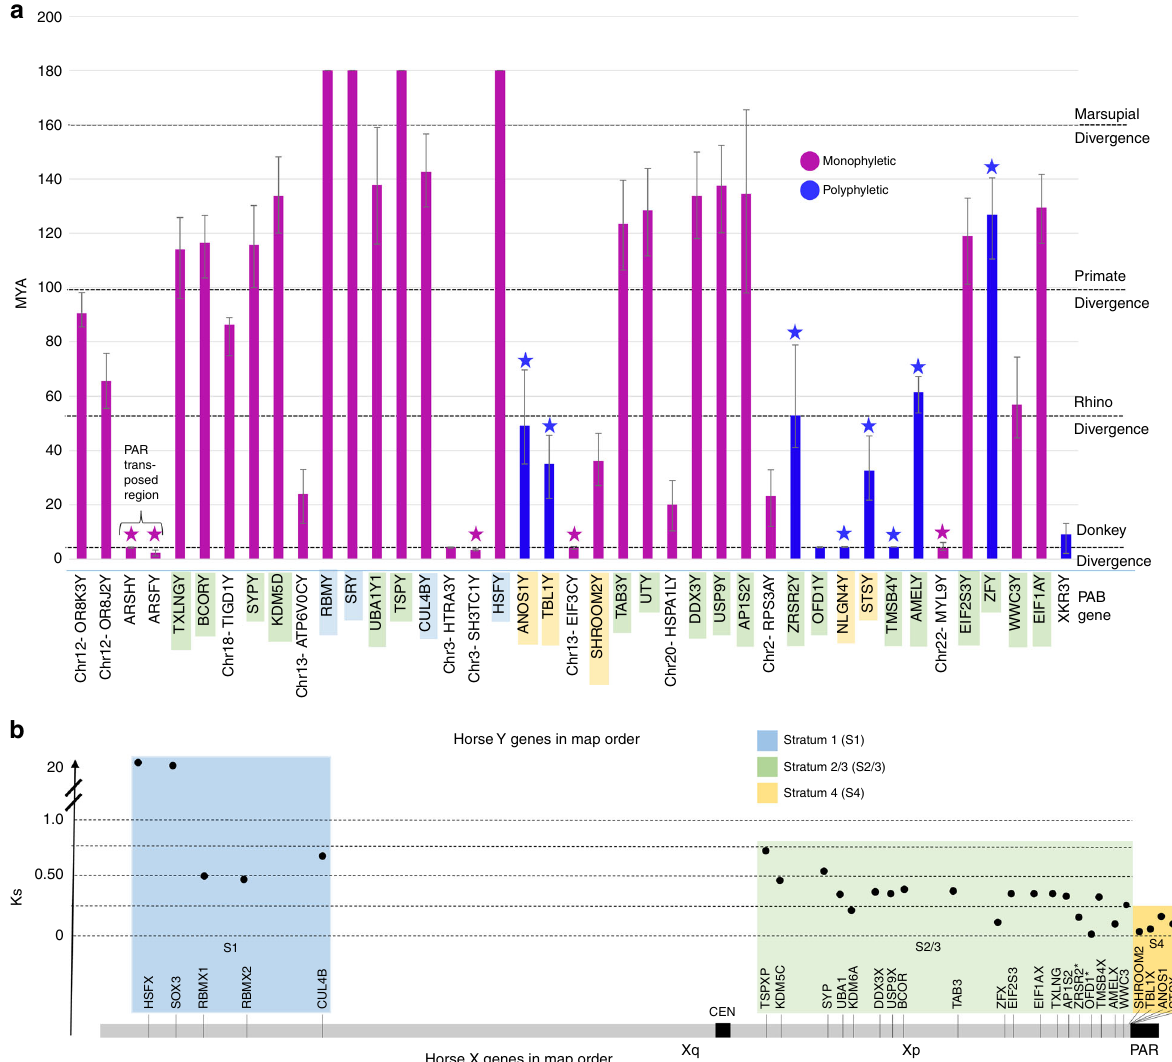
Fig. 4 Horse MSY gene acquisition and evolutionary strata. a eMSY genes in map order are shown in x -axis; vertical bars in y -axis correspond to individual MSY genes, show their divergence time from X-gametologs/ autosomal paralogs, and are color coded according to phylogenetic patterns; stars above vertical bars indicate genes that tested positive for gene conversion; MSY gene symbols are color shaded according to their correspondence to evolutionary strata in the X chromosome as shown below; error bars show 95% Con fi dence Intervals estimated in MCMCTREE ; b X-gametologs in map order are shown in x -axis and color coded according to evolutionary strata along the horse X chromosome; Ks values are plotted in y